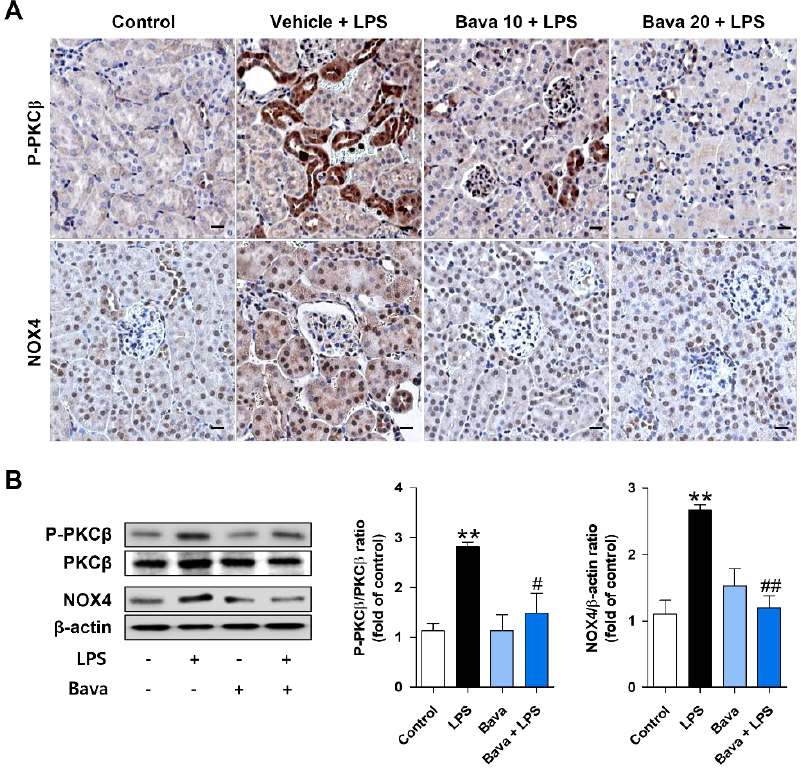
Figure 4. Bavachin decreases PKC β activation and NOX4 expression in LPS-induced AKI mice and LPS-treated HK-2 cells. ( A ) Immunohistochemical detection of phospho-protein kinase C β (P - PKCβ) and NADPH oxidase 4 (NOX4) in kidney tissues using DAB. Nuclei were counterstained with hematoxylin (original magnification, 200×; scale bars, 20 μm; n = 3 mice per group). ( B ) HK-2 cells were pretreated with bavachin 0.1 μg/mL for 1 h and then treated with 1 μg/mL LPS for 1 h. The protein levels of p- PKCβ and NOX4 were analyzed by Western blotting, quantified using ImageJ software, and normalized to PCK β and β -actin, respectively ( n = 3). Data are presented as mean ± SEM. ** p < 0.01 vs. control; # p < 0.05, ## p < 0.01 vs.